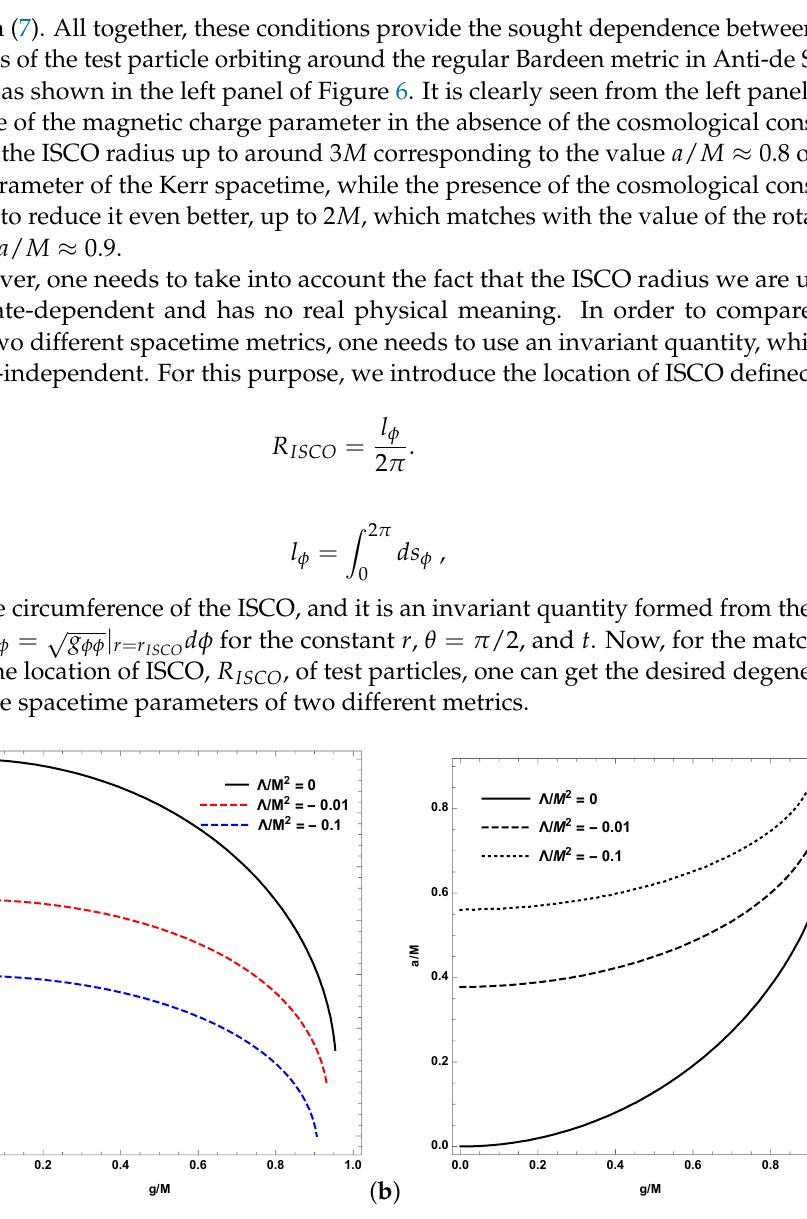
Figure 6. The dependence of the ISCO radius from magnetic charge of the black hole and cosmological constant Λ (panel ( a )), and parameter a from parameters g and Λ for the same ISCO location (panel ( b